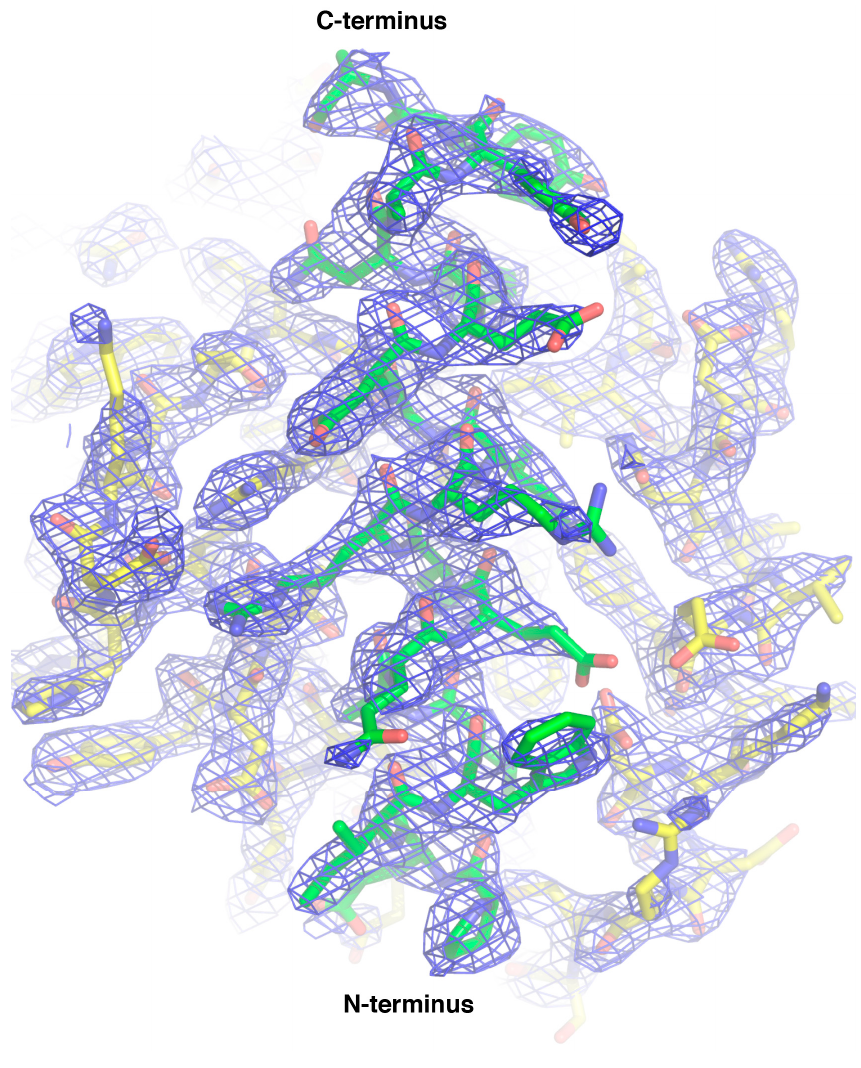
Figure 4. 2Fo-Fc electron density maps of CNP058:Bim BH3 domain complex. Electron density map encompassing the hydrophobic binding groove of CNP058 in complex with Bim BH3. CNP058 is shown as yellow sticks, whereas Bim BH3 is shown as green sticks. The electron density map is shown as a blue mesh contoured at 1 δ .